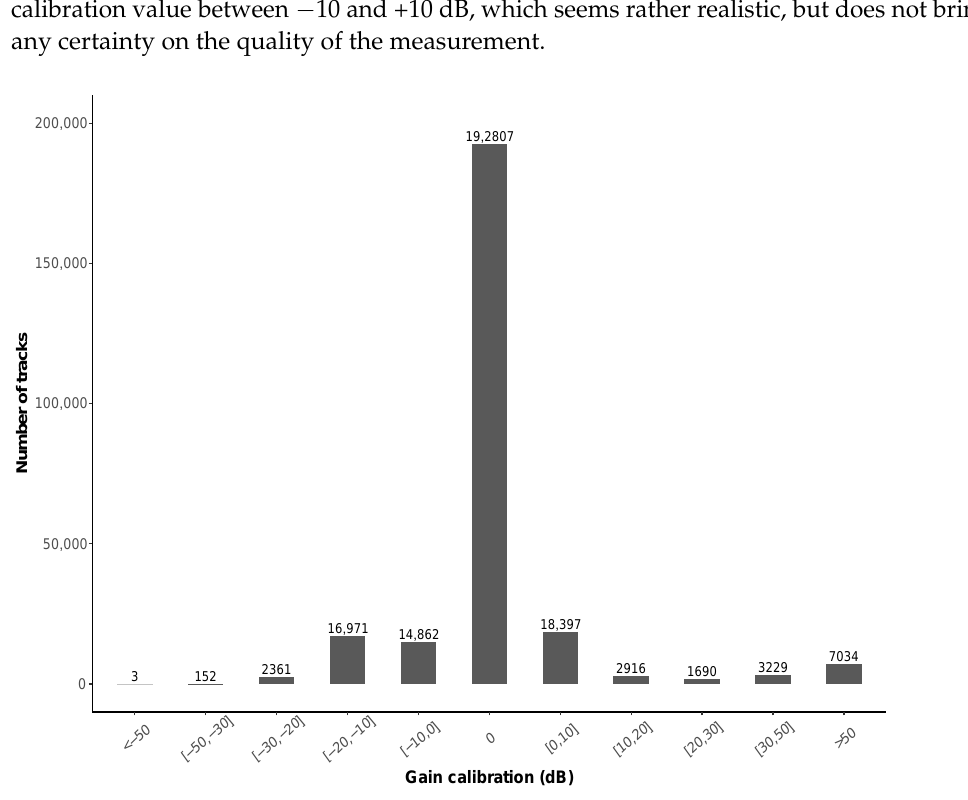
Figure 12. Number of tracks in function of ‘gain_calibration’